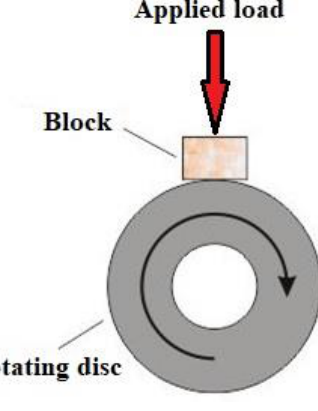
Figure 3. Block-on-disc configuration.